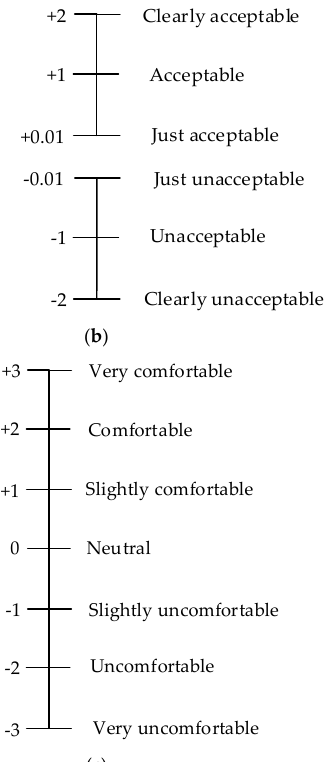
Figure 4. Rating scales: ( a ) Thermal sensation ( b ) Thermal acceptability ( c ) Thermal comfort.